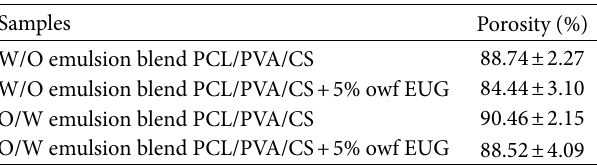
Table 1: Porosity measurement of electrospun PCL/PVA/CS fiber mats with and without loaded